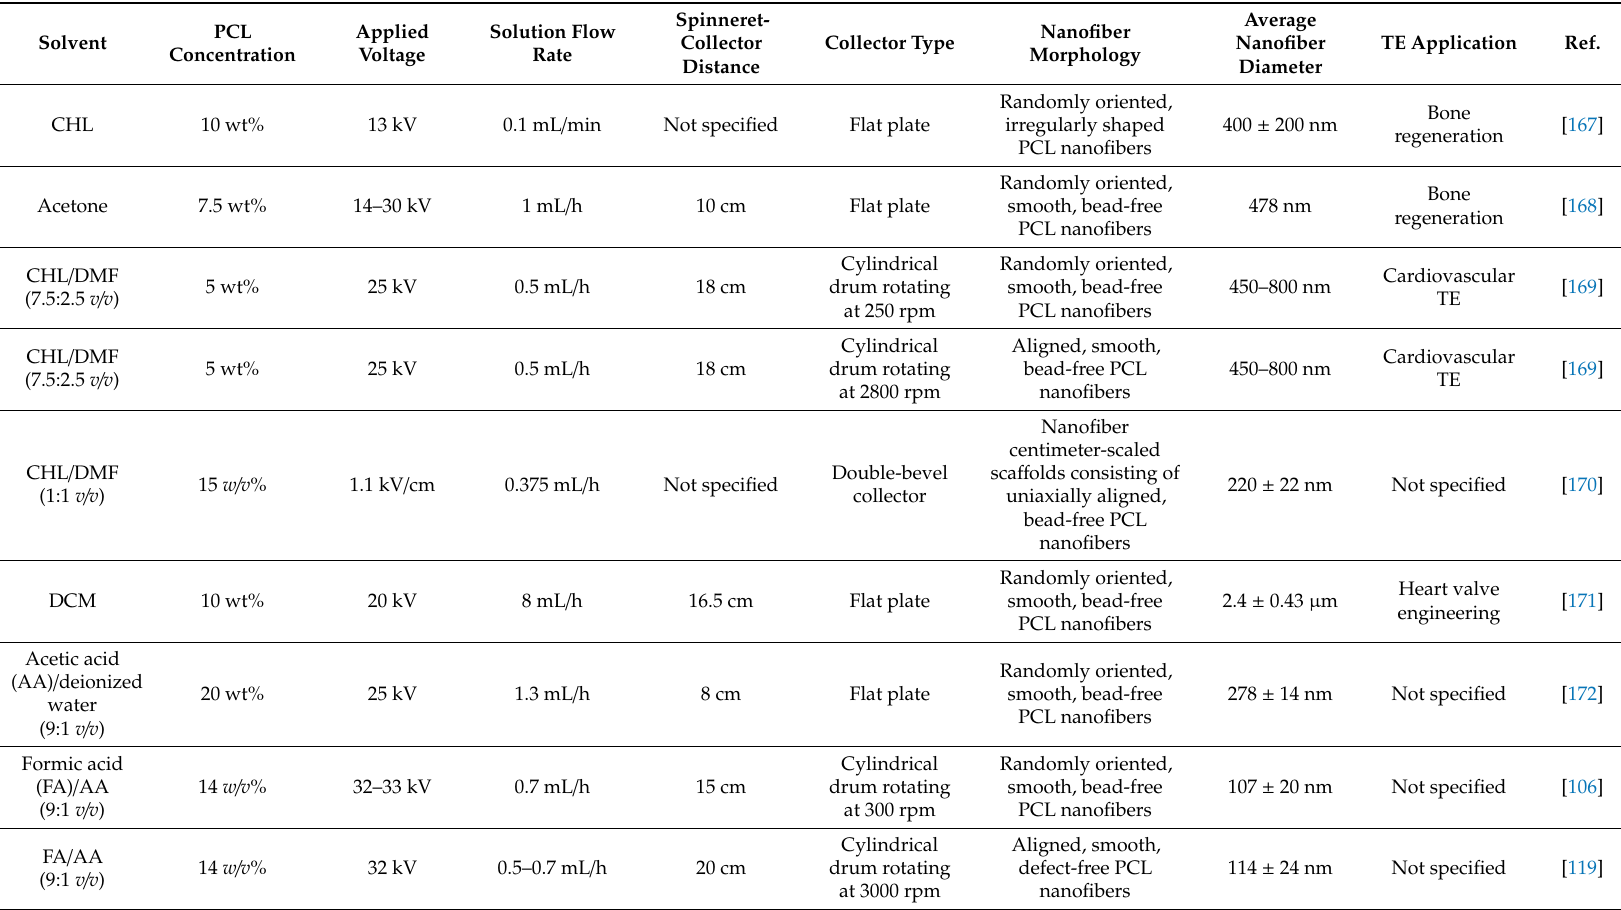
Table 4. Di ff erent electrospun PCL sca ff olds for TE